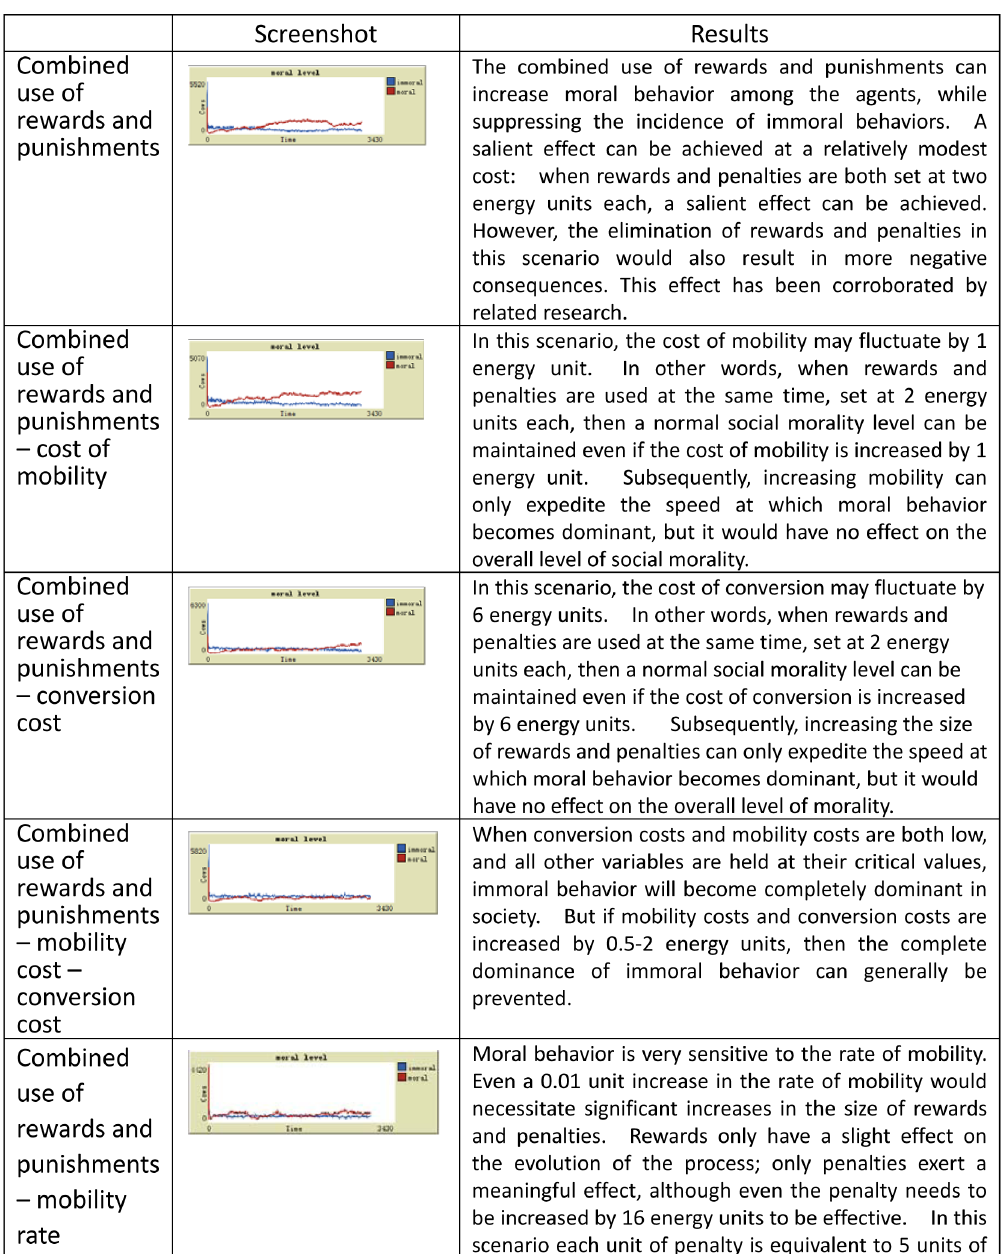
Figure 3. Simulation results with univariate controls. In this type of analysis, we can observe the effects of the changes in the overall social moral level by adjustments of one variable parameter value. Critical state parameter values are found after repeated experiments. Some results consistent with other research conclusions. Such as incentives are an expensive means of management [31] and